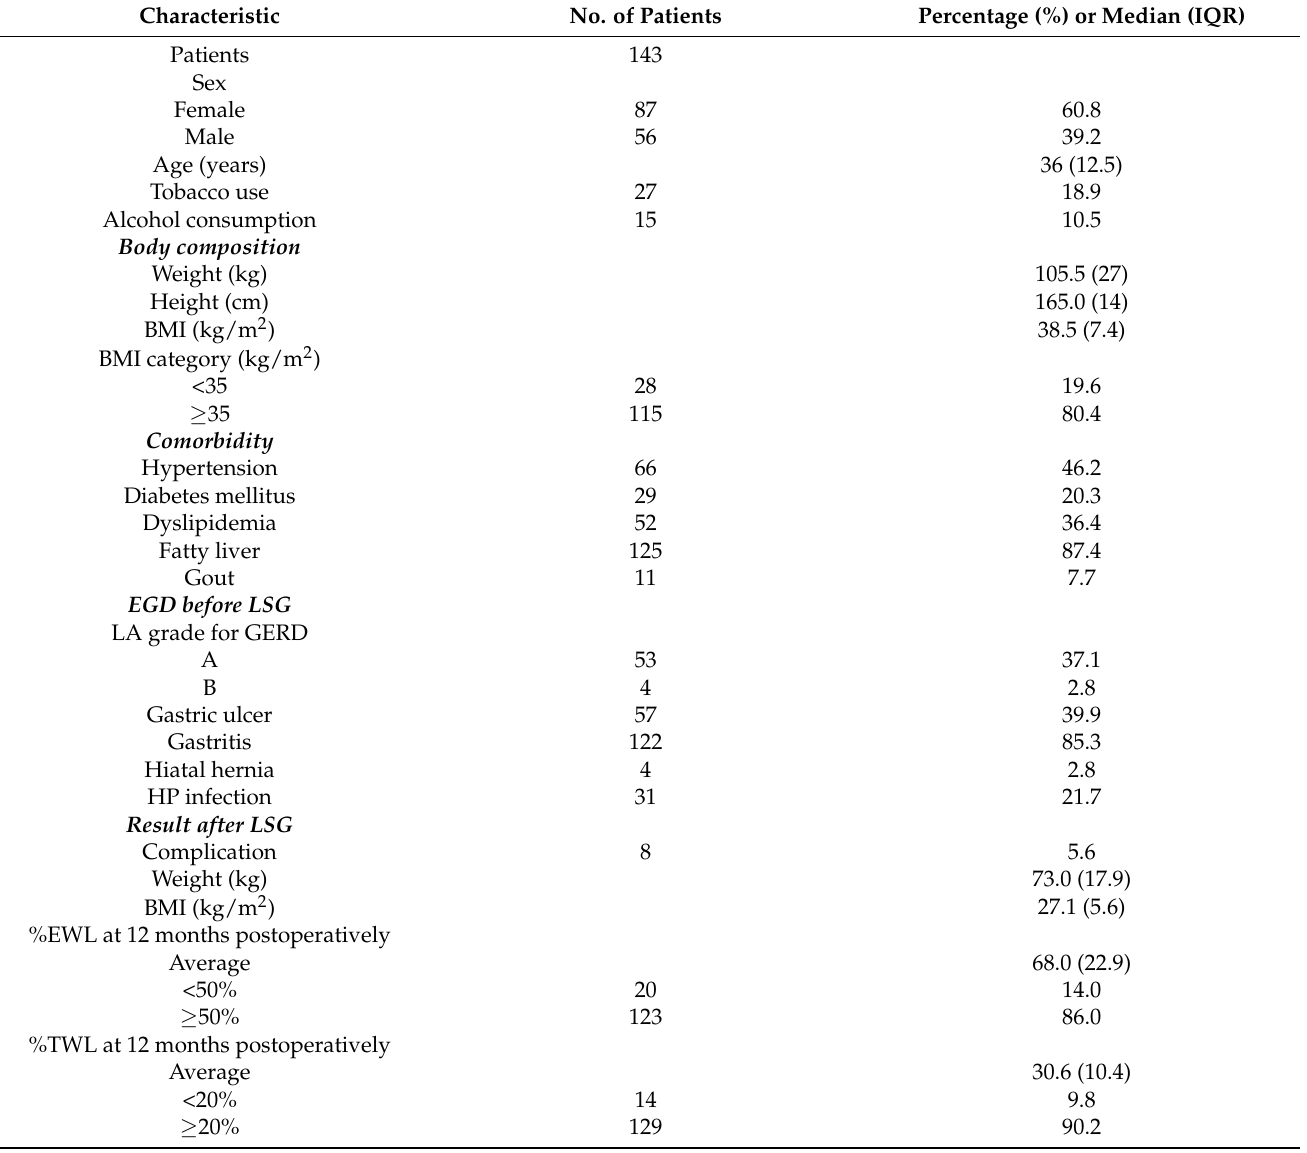
Table 1. Patients’ baseline